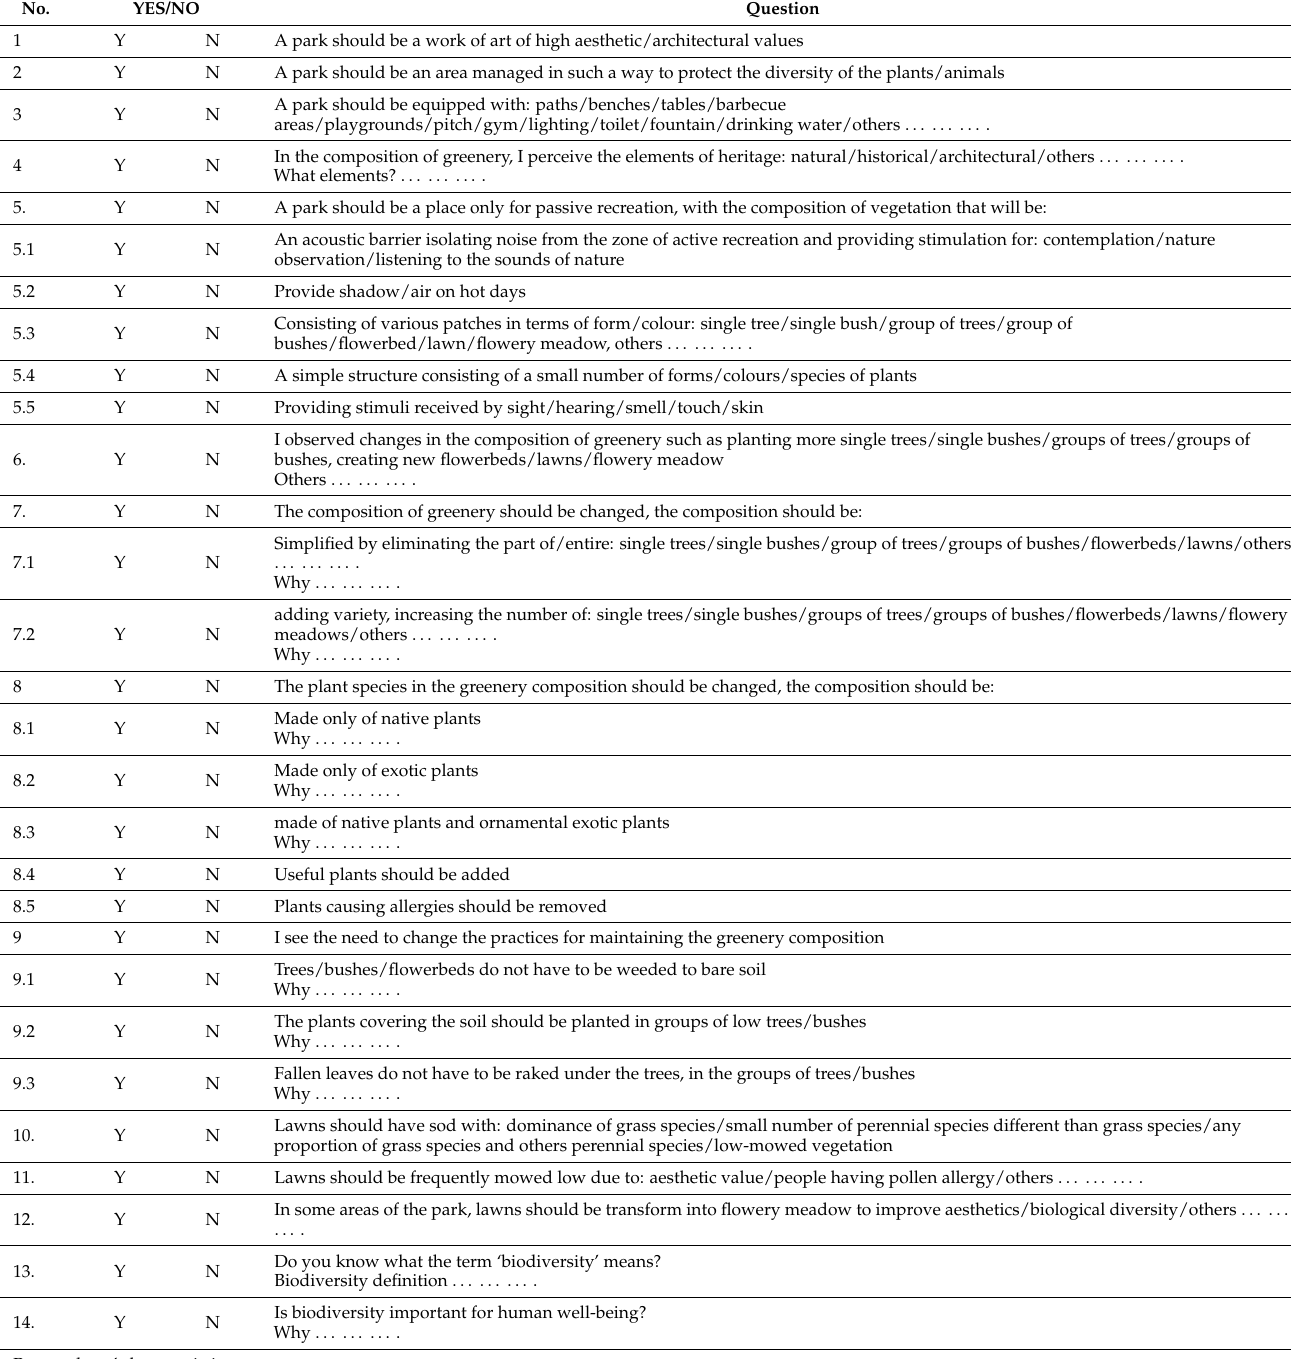
Table A1. Questionnaire for research on students’ perception of the vegetation cover pattern in urban parks. Please answer strongly YES or definitely NO to the questions below. If your answer is YES, underline which statements you agree with. If your answer is NO, go to the next